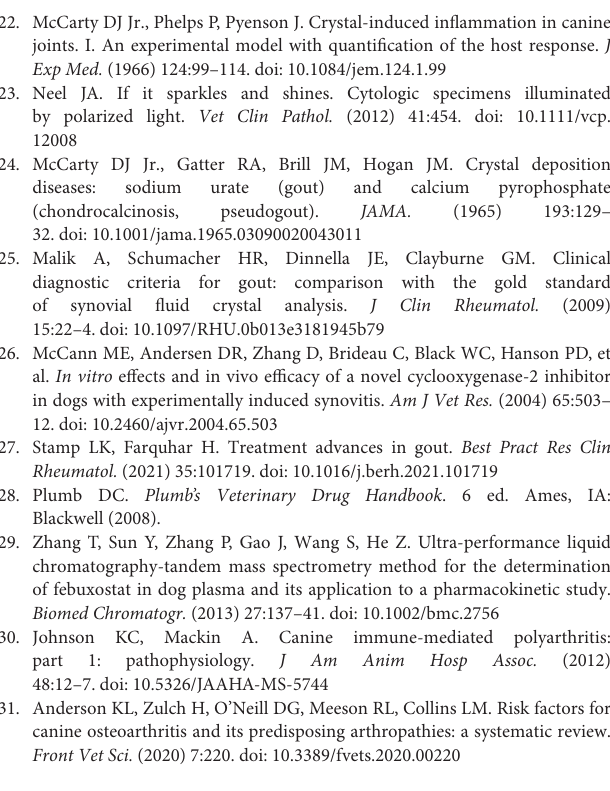
Supplementary Figure 1 | Clinical history of the cat before referring to our hospital. Supplementary Figure 2 | Treatment schedule of dog 2. Supplementary Figure 3 | Scanning electron microscopy analysis of monosodium urate crystals. (A) SEM-EDS results of commercially available MSU Supplementary Table 1 | Complete blood count and serum chemistry